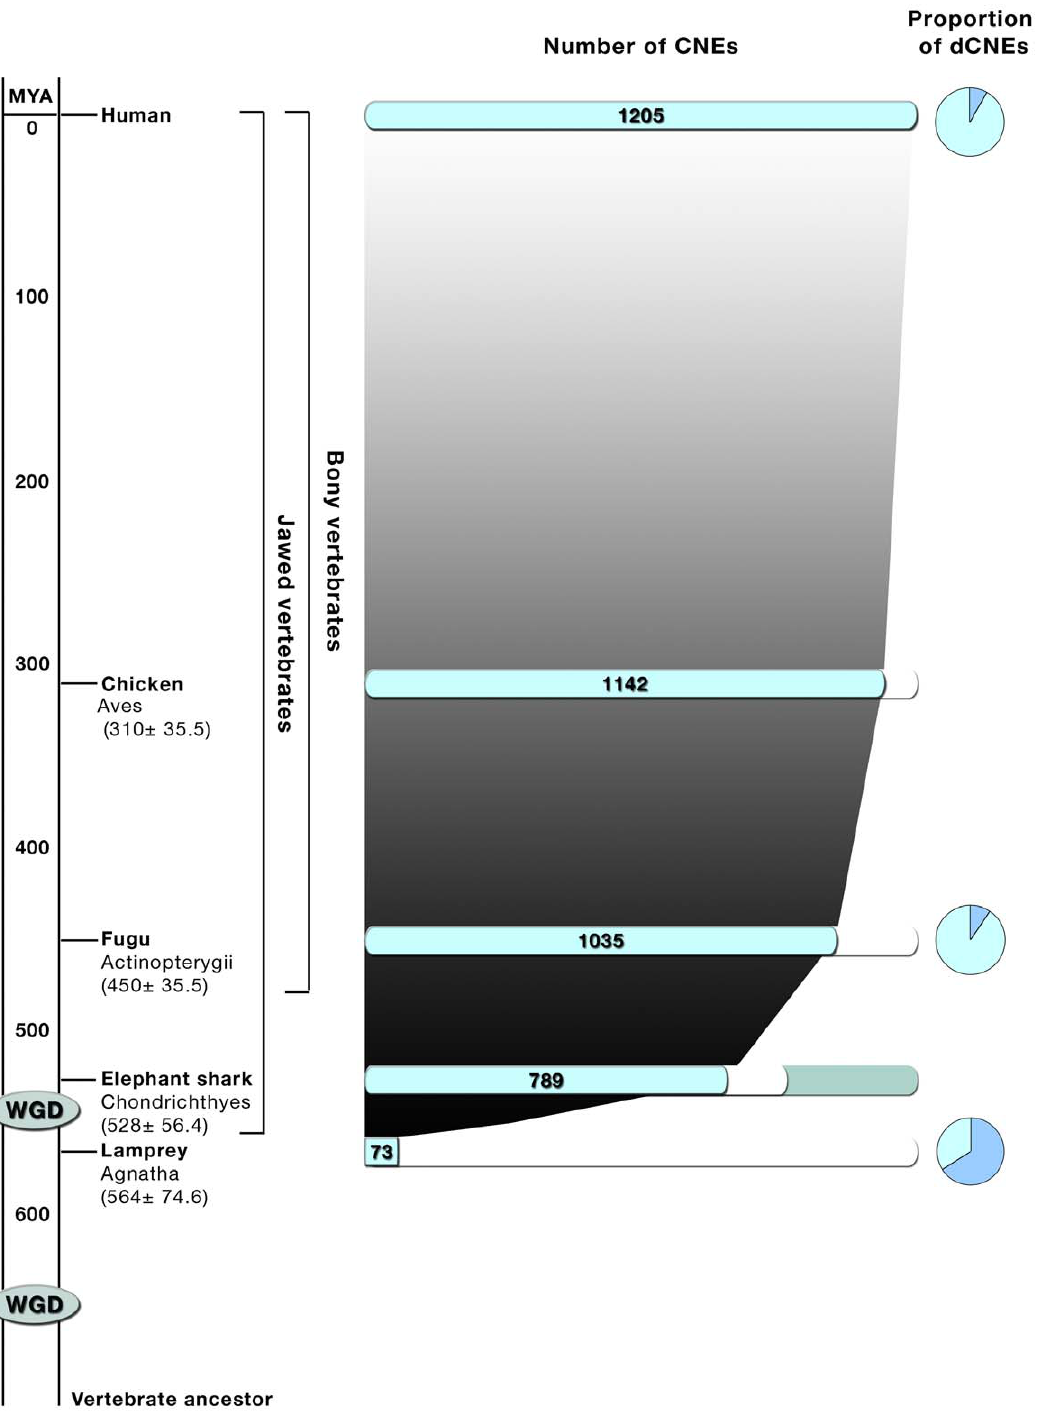
Figure 4. Proposed model of early vertebrate evolution, genome duplications, and expansion of CNE repertoire. Evolution of CNE repertoire occurred early in the history of vertebrates, coinciding with proposed genome duplication events and the emergence of agnathans. CNEs are barely detectable in invertebrate genomes and therefore must have evolved very early in the ancestral vertebrate, coinciding with whole genome duplication (WGD) events. The lamprey genome possesses a much smaller set of CNEs than sharks and other jawed vertebrates. This suggests that a large number of CNEs evolved and became fixed in all gnathostomes within a relatively short time period, between the emergence of agnathans and Chondrichthyes, coincident with the second proposed large scale genome duplication in jawed vertebrates. The proportion of CNEs that are found to be duplicated in the human genome is shown for each species (proportion of dCNEs); over half of the human CNEs that have matches to lamprey are found to be duplicated in the human genome. Timescale and divergence times taken from [15]. The elephant shark genome has a maximum coverage of 75% [3] and the light blue area represents the unsequenced portion.